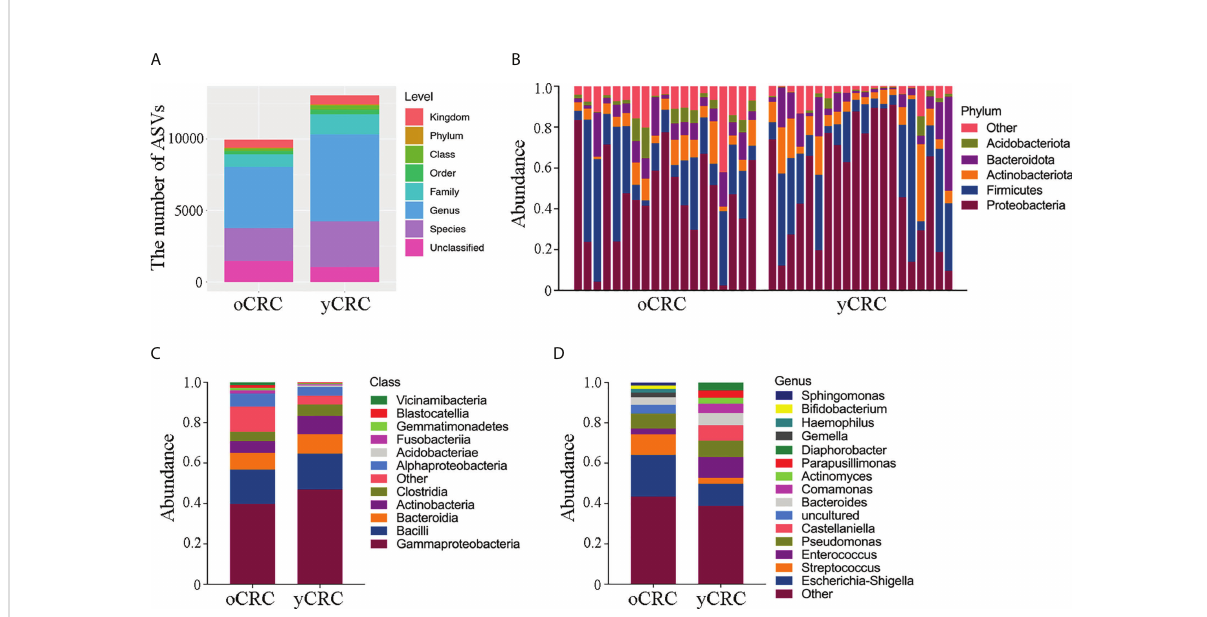
FIGURE 2 Abundance and diversity of tumor microbiota in patients with oCRC and patients with yCRC. (A) Statistical chart of microbial diversity results of each species level by observed count of amplicon sequence variants (ASVs). (B) Bar plots displaying taxonomic composition at the major phyla of each sample. (C, D) Relative abundance of the tumor microbiota in the two groups at class level and genus